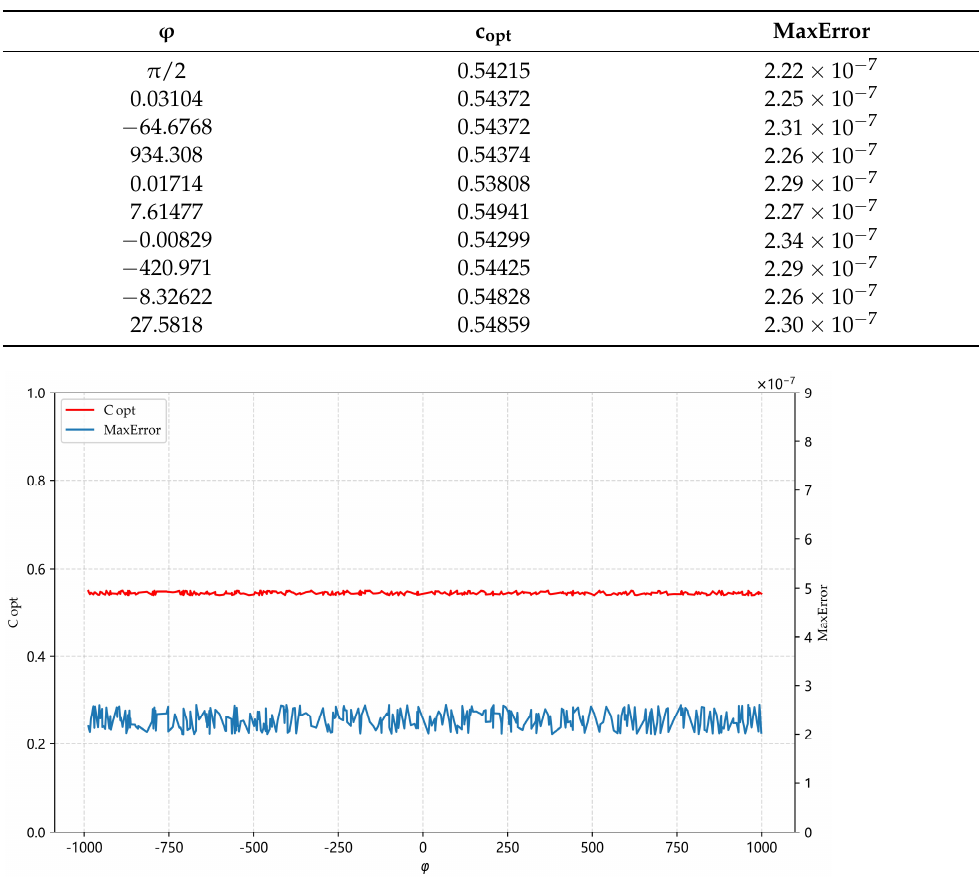
Table 2. Partial results of Experiment 1.